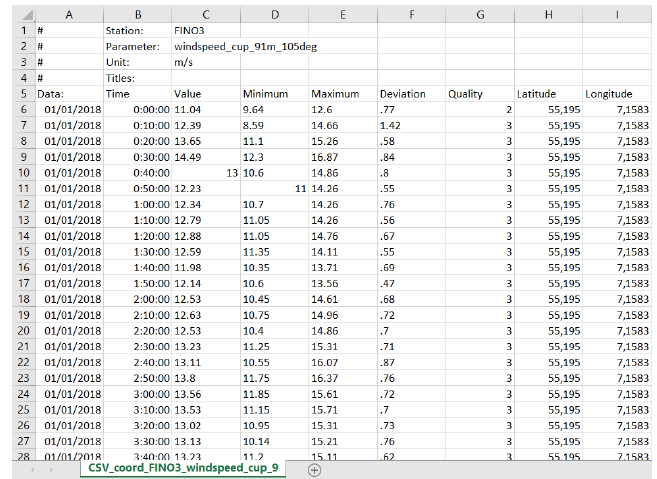
Figure 19. FiNO 3 : Downloaded parameters in .csv format. Data source: [128].